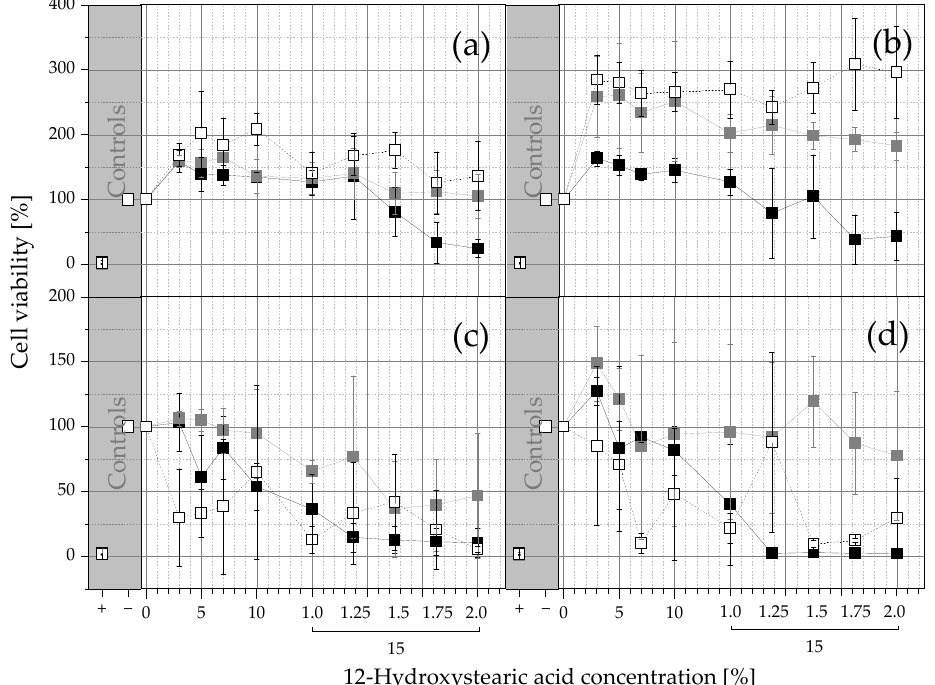
Figure 6. Long-term toxicity–cell viability levels after exposure to ISFO extracts: ( a ) 3T3 cells after 24 h;